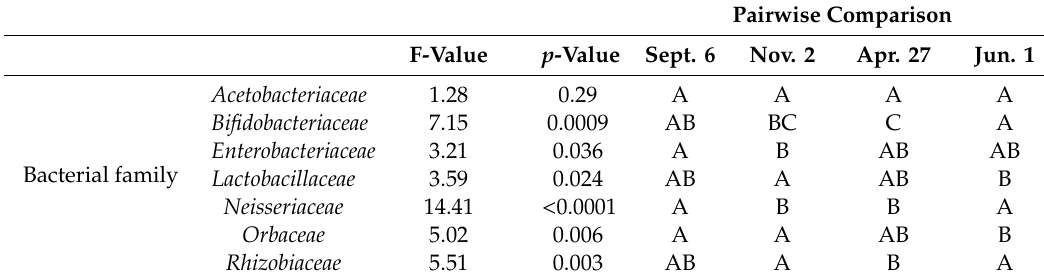
Table 1. Statistical analyses and pairwise comparisons of relative abundance of each bacterial family forming the core microbiota between the four sampling times: September 6, after the last honey flow; November 2, before entering wintering room; April 27, after wintering and removal from wintering room; June 1, during first honey flow of 2018. Sampling times are significantly different if they are identified with different letters.